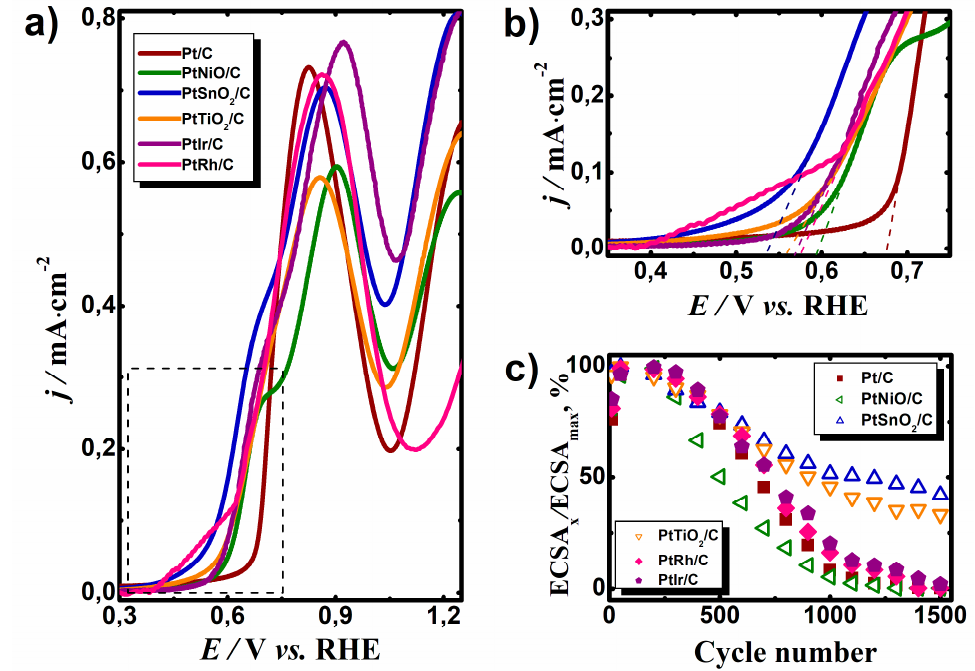
Figure 3. ( a ) The forward scans of cyclic voltamperograms of catalysts in 0.5 M C 2 H 5 OH + 0.5 M solution; potential scan rate was 5 mV · s –1 , ( b ) enlarged forward scans of cyclic voltamperograms, ( c ) the H 2 SO 4 solution; potential scan rate was 5 mV·s –1 , ( b ) enlarged forward scans of cyclic dependence electrochemically active surface area of catalysts, which was normalized to the maximum voltamperograms, ( c ) the dependence electrochemically active surface area of catalysts, which was electrochemically active surface area of catalysts from the cycle normalized to the maximum electrochemically active surface area of catalysts from the cycle numbers.